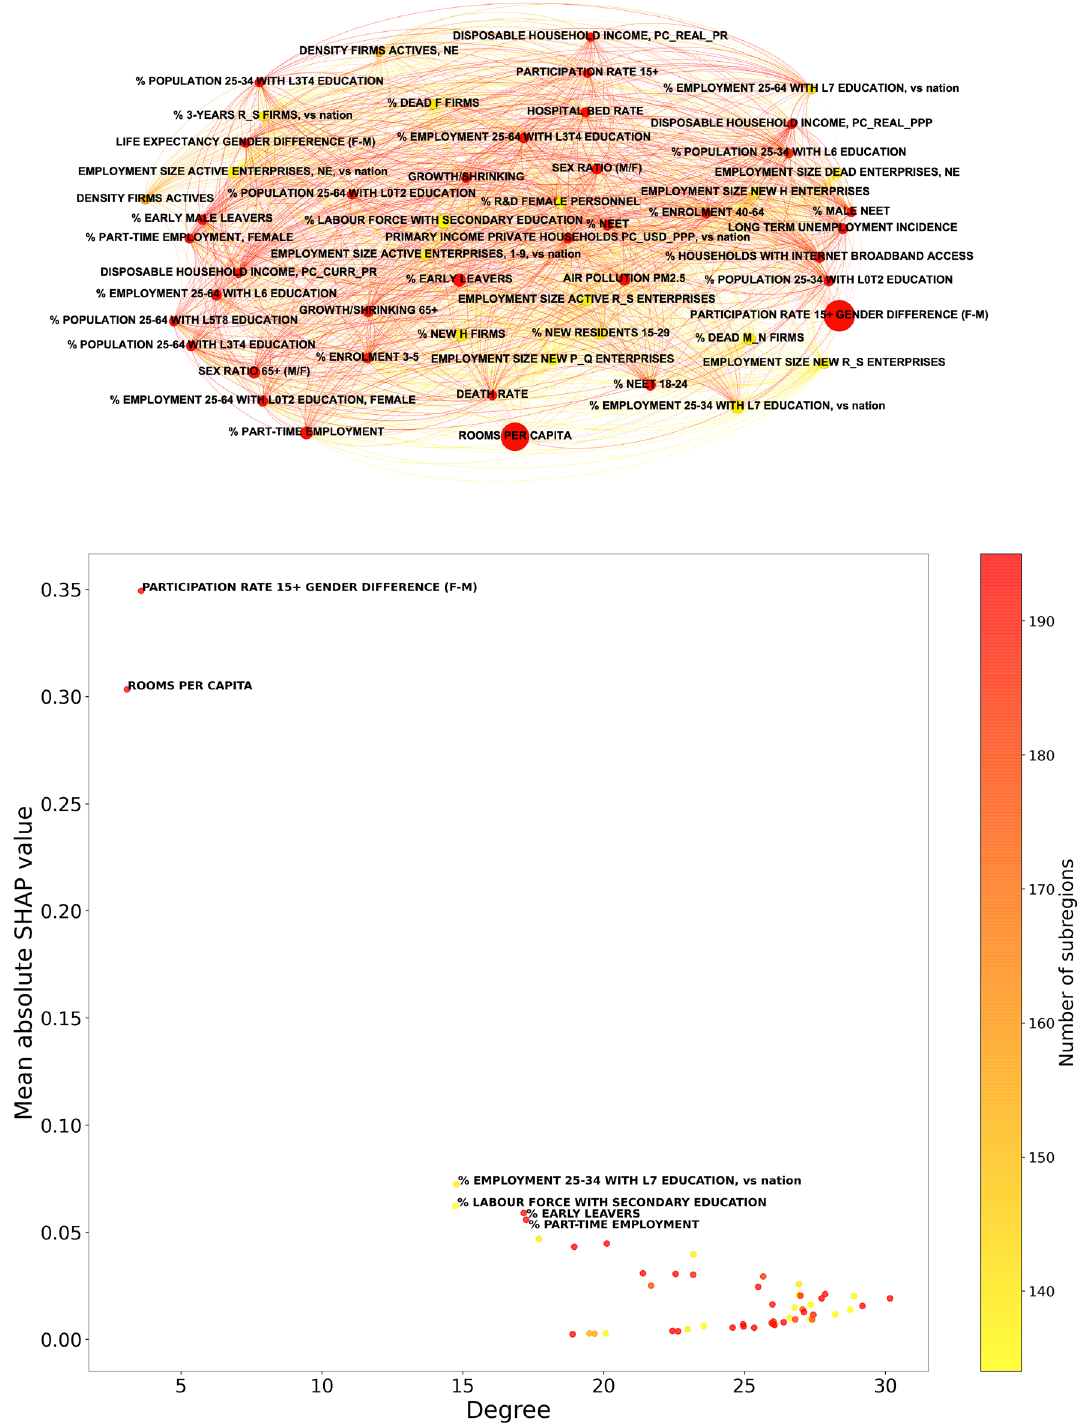
Figure 4. Top: competition network of the selected OECD indicators, determined from the importance rankings of their mean absolute SHAP values for each subregion considered in the study. Bottom: scatter plot illustrating the relation between the mean absolute SHAP value and the degree in the competition network, for indicator; labels are reported only for features whose mean absolute SHAP value exceeds 0.05. In both panels, the color of points indicates the number of regions for which the considered indicator is available in the dataset. In the top panel, the size of each node increases with the mean absolute SHAP value of the corresponding indicator. The results confirm that both PARTICIPATION RATE 15+ GENDER DIFFERENCE (F-M) and ROOMS PER CAPITA are outstandingly relevant in their capability to predict EQI. The meaning of all the feature labels is explained in the Supplementary Data S1–S4. The network representation in top panel is generated with Gephi 0.9.5 48